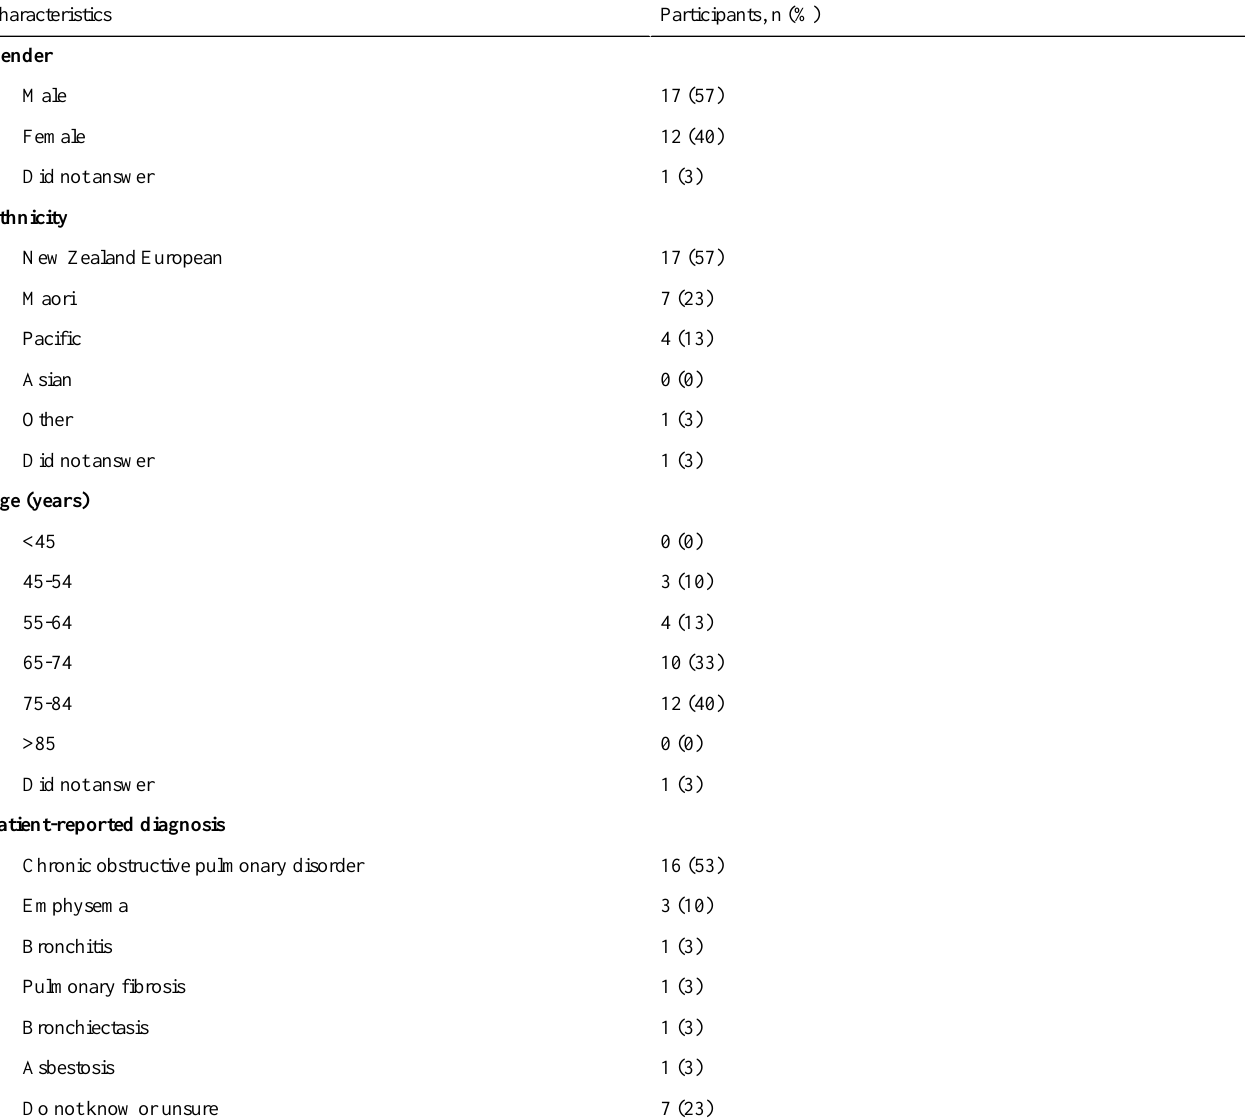
Table 1. Demographic and clinical characteristics